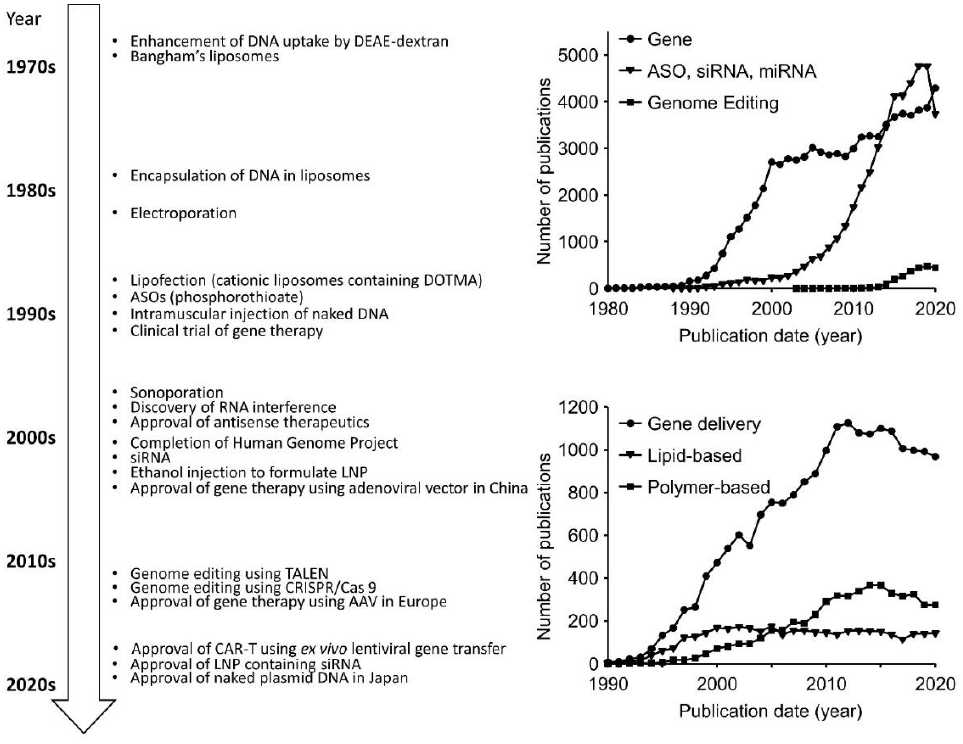
Figure 1. History of nucleic acid and gene medicines. The number of publications were searched via PubMed on 18 January 2021. Search queries: for “Gene”, (“Gene therapy” or “gene delivery”); for “ASO, siRNA, miRNA”, ((“siRNA” or “miRNA” or “microRNA” or “antisense oligonucleotides”) and (“therapy” or “delivery”)); for “Genome editing”, (“genome editing” and (“therapy” or “delivery”)); for “Gene delivery”, (“gene delivery”); for “Lipid-based”, ((“liposome” or “liposomes” or “lipid nanoparticle” or “lipid nanoparticles”) and (“gene delivery” or “gene therapy”)); for “Polymer-based”, ((“polymer” or “polymers” or “polymeric micelles” or “dendrimers” or “polyion complexes”), and (“gene delivery” or “gene therapy”)).